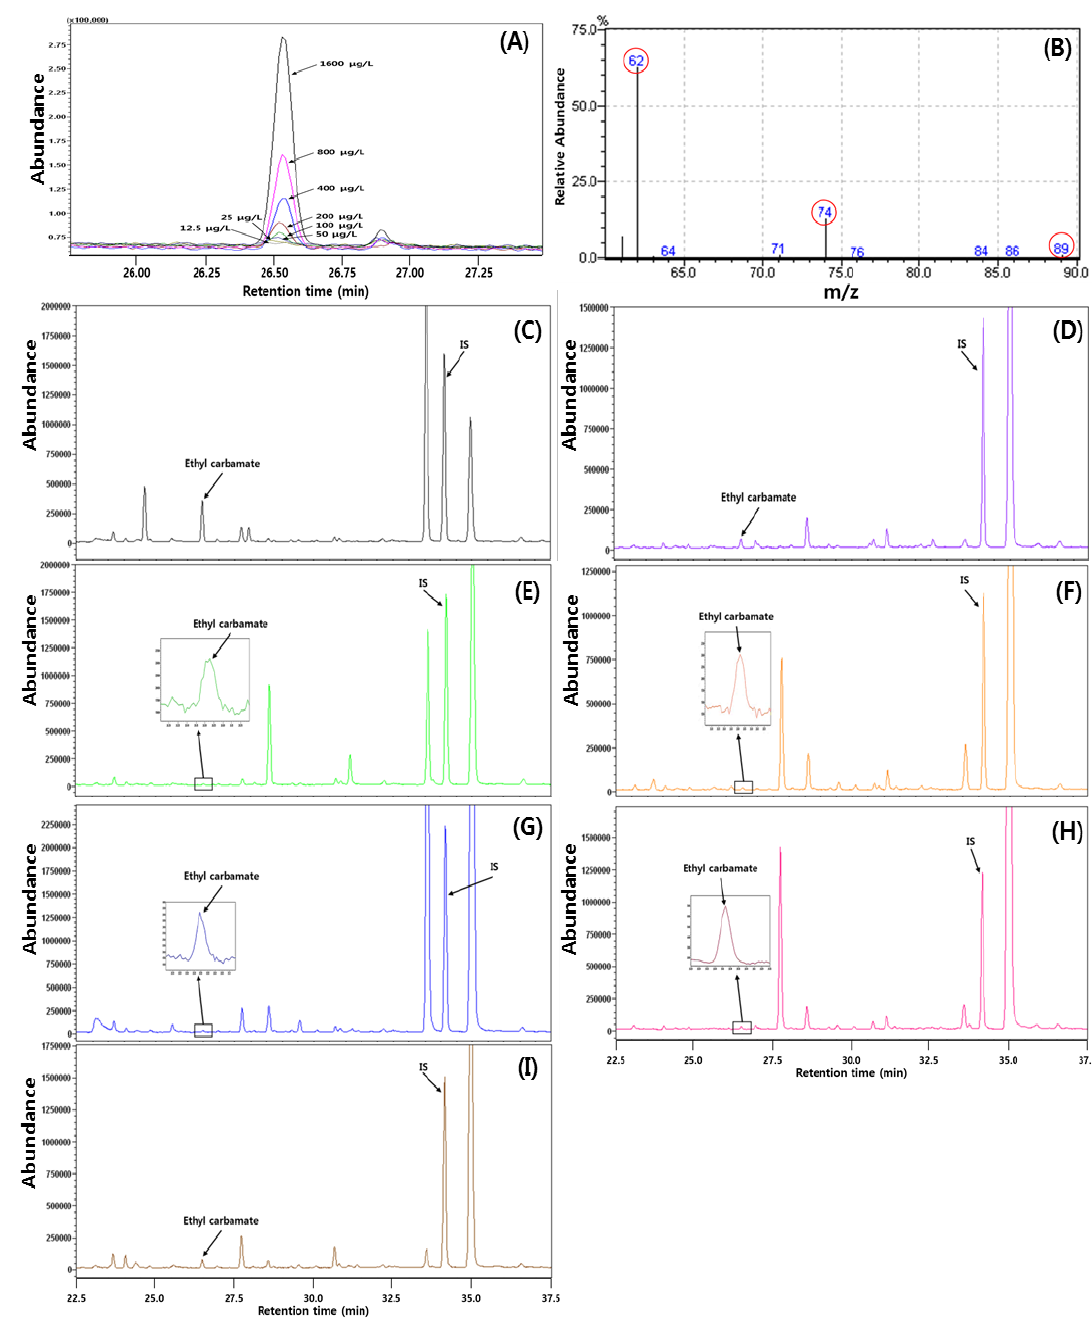
Figure 2. GC-MS-SIM chromatogram (62 m/z) of ethyl carbamate in standards and fruit wines: ( A ) ethyl carbamate of 12.5 – 1600 μg/L; ( B ) mass spectrum of ethyl carbamate; ( C ) maesil wine; ( D ) black raspberry wine; ( E ) peach wine; ( F ) apple wine; ( G ) plum wine; ( H ) red grape wine; ( I ) white grape wine. IS: internal standard, butyl carbamate.